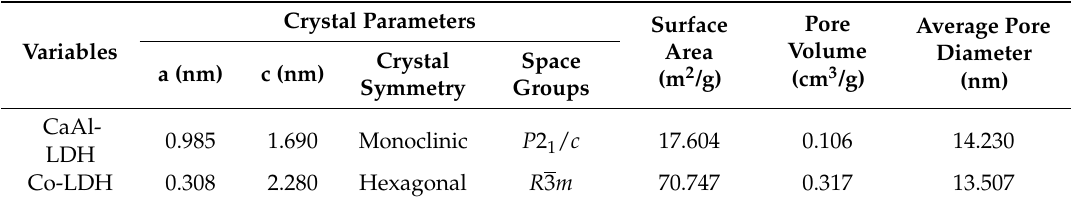
Figure 5. N 2 adsorption and desorption isotherm loop ( a ) and Barrett-Joyner-Halenda (BJH) pore-size distribution ( b ) for CaAl-Cl-LDH and Co-adsorbed LDH (pH = 6). Table 1. Cell parameters and Brunauer-Emmett-Teller (BET) analysis results of CaAl-Cl-LDH and